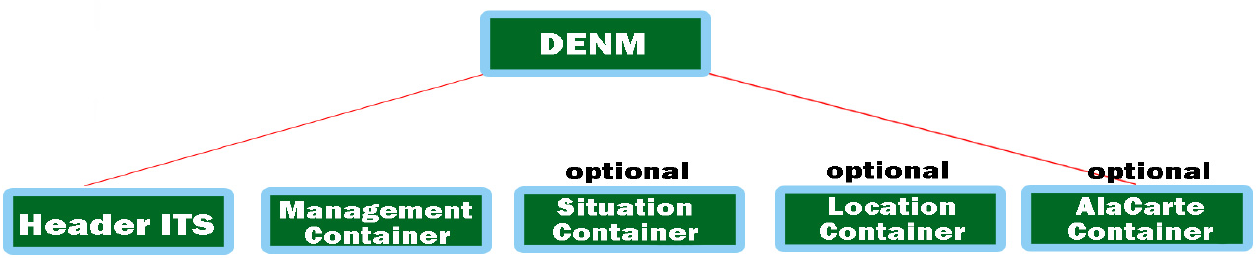
Figure 5. General structure of DENM messages.